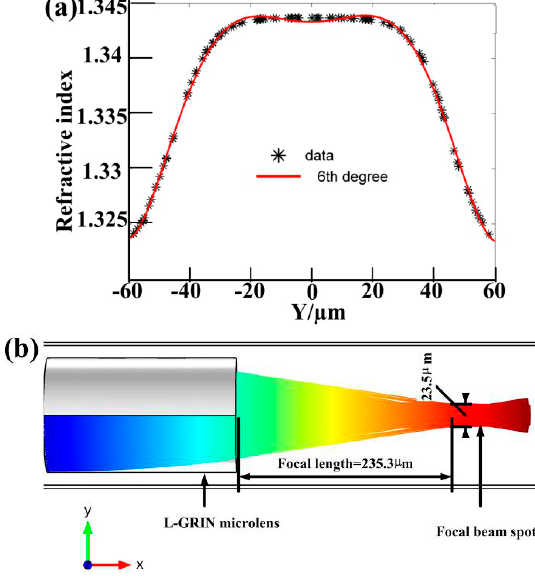
Figure 7. ( a ) The fitting refractive index profile of the simulated data and six-degree polynomial at x = 125 μm with Q core = 2.5 × 10 4 and Q core = 4 × 10 4 pL/s; ( b ) Beam transmission and focusing process.